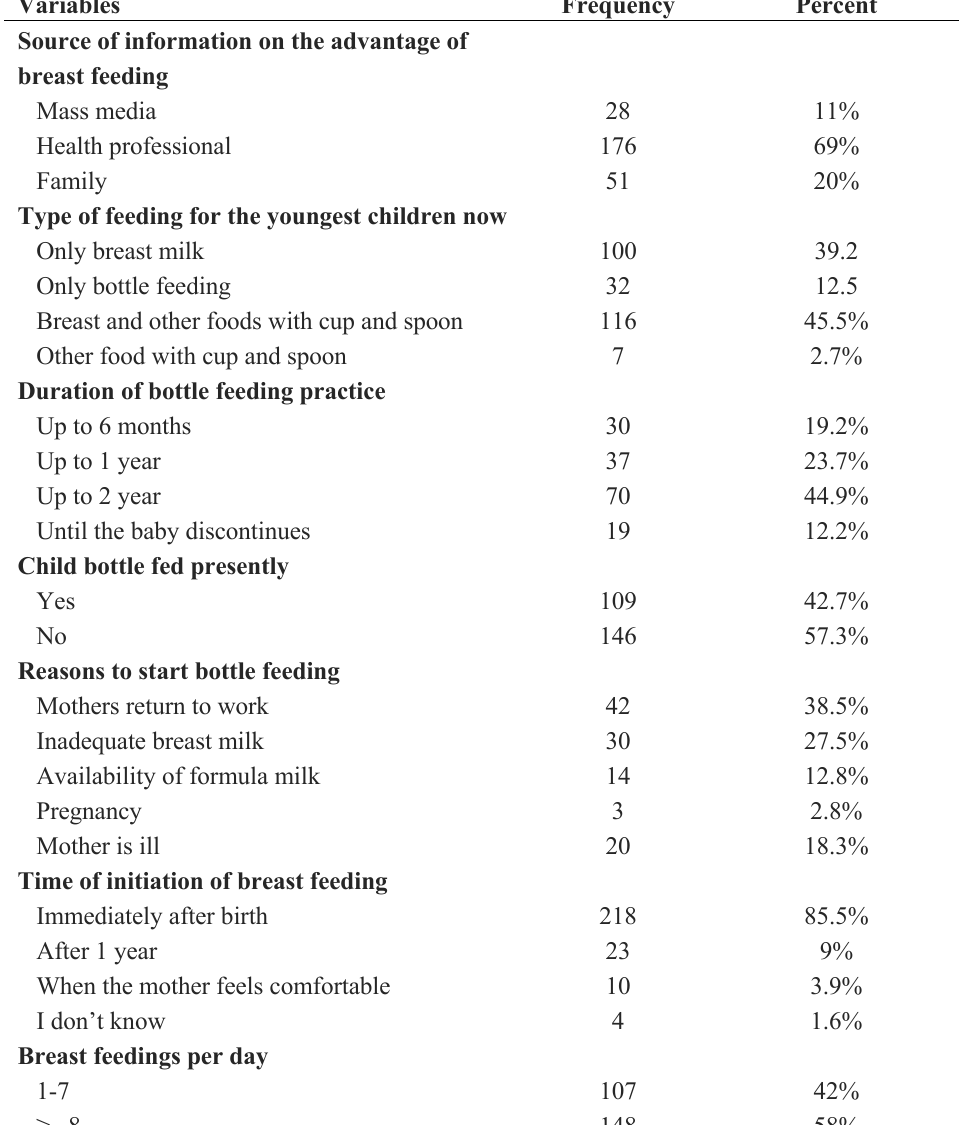
Table 3. Child feeding practices among mothers with infants less than 24 months of age in Woldia General Hospital, Ethiopia, 2019